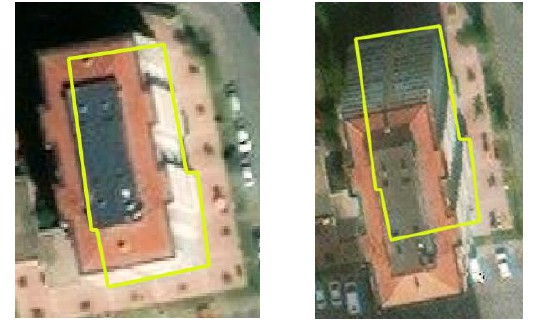
Figure 11. One example from False positive result. Yellow: Vector dataset. The building height is 42 meters.